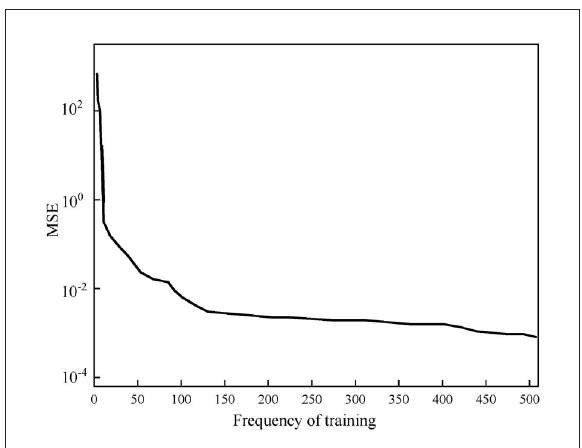
FIGURE6 The results of training